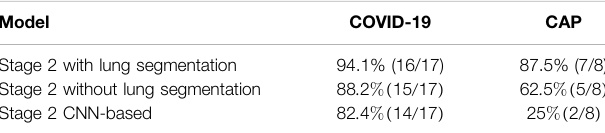
TABLE 5 | Correctly predicted cases using only stage two without applying the fi rst